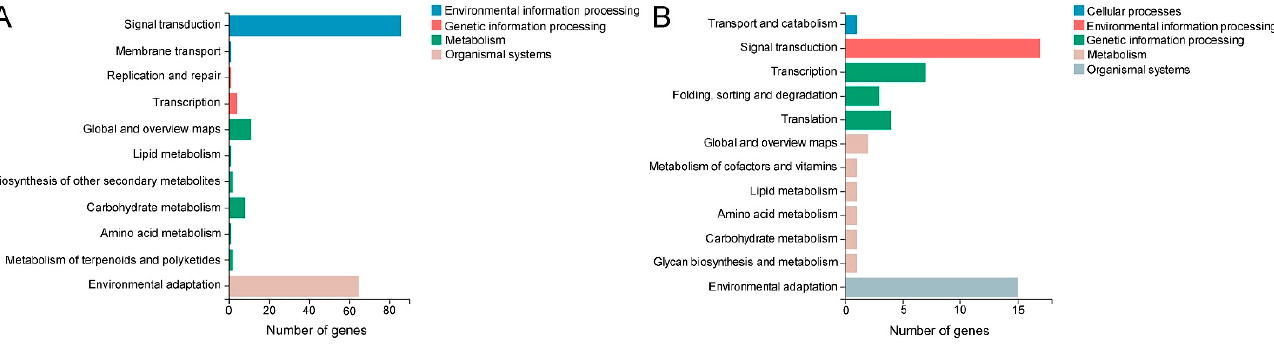
Figure 9. KEGG classification analyses of differentially expressed genes (DEGs) in ( A ) MAPK signaling pathway plant and ( B ) DEGs encoding transcription factors.